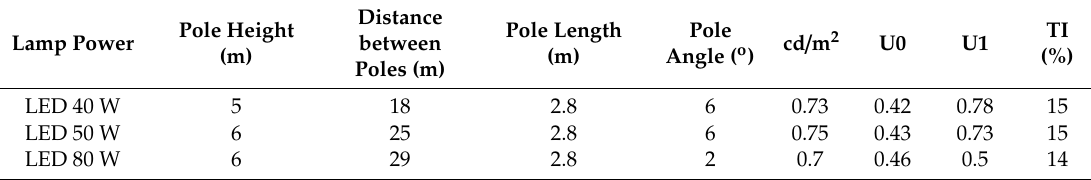
Table 2. Simulation results of Alternative 1.